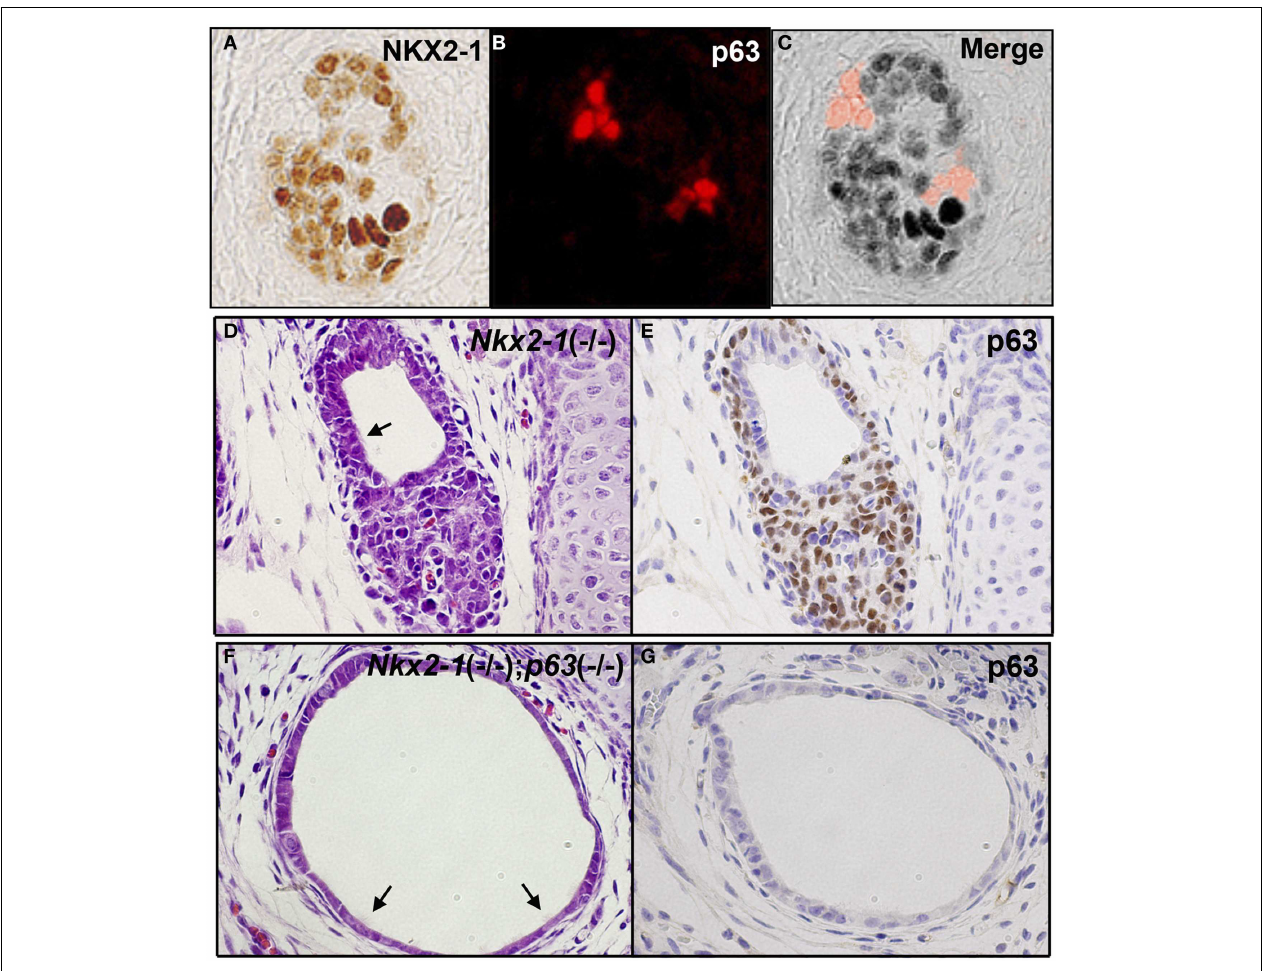
p63 immunohistochemistry (E) . p63 is expressed in the stem/basal cell patterns. (F,G) SCN from E18.5 Nkx2-1 ; p63 -double null embryos for H&E (F) and p63 immunohistochemistry (G) . Note that the monolayer of p63-negative cells remain in SCN from Nkx2-1 ; p63 -double null embryos. Arrows indicate ciliated cells observed in the cystic